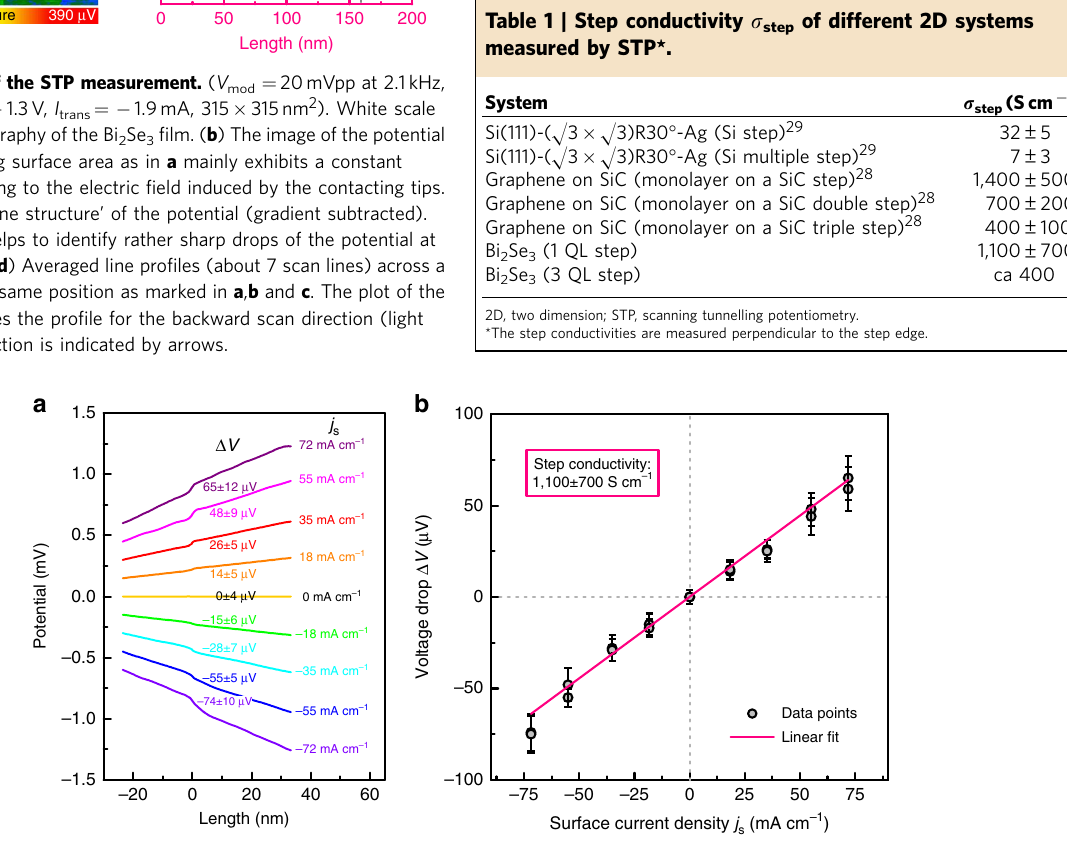
Figure 3 | Step conductivity of a 1 QL step. ( a ) Averaged line profile of the potential in the vicinity of a 1-QL step of Bi 2 Se 3 for different surface current densities j s from (cid:2) 72mAcm (cid:2) 1 to 72mAcm (cid:2) 1 . For clarity, the line profiles are vertically offset. The value of the voltage drop D V at the step edge is indicated. ( b ) Voltage drop at a 1-QL step as a function of surface current density. The linear fit yields the conductivity of a 1-QL step to 1,100 ± 700Scm (cid:2) 1 . The individual error bars of the voltage drops represent the maximal error of each measured voltage drop as estimated from the noise level.